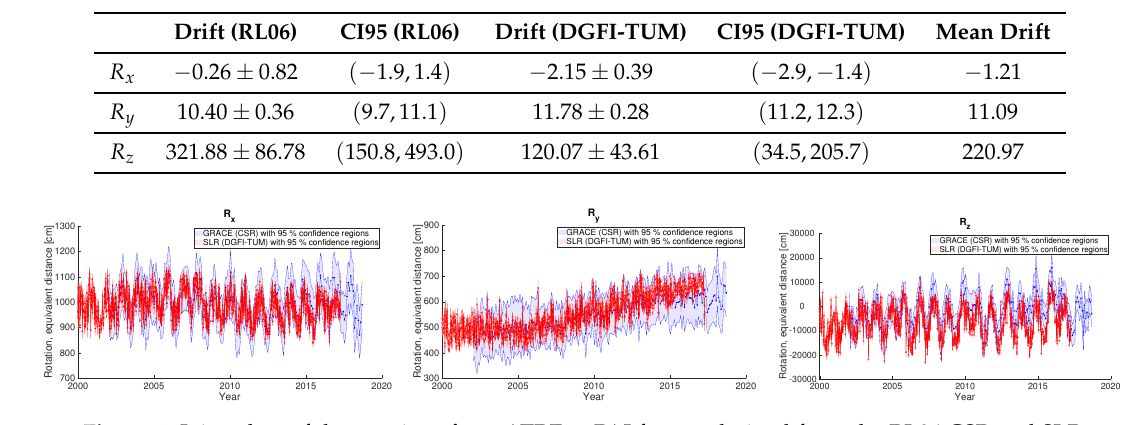
Figure 4. Joint plots of the rotations from ATRF to PAI frames derived from the RL06 CSR and SLR DGFI-TUM Stokes coefficients with their respective 95% confidence regions: ( left ) R x ; ( middle ) R y ; and ( right ) R z . Color code: CSR, curve in blue, confidence region in light blue; DGFI-TUM, curve in red, confidence region in light red. Units: cm